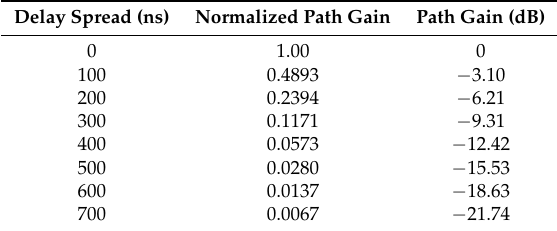
Table 2. Parameters of Power delay profile: delay spread in (ns) and path loss